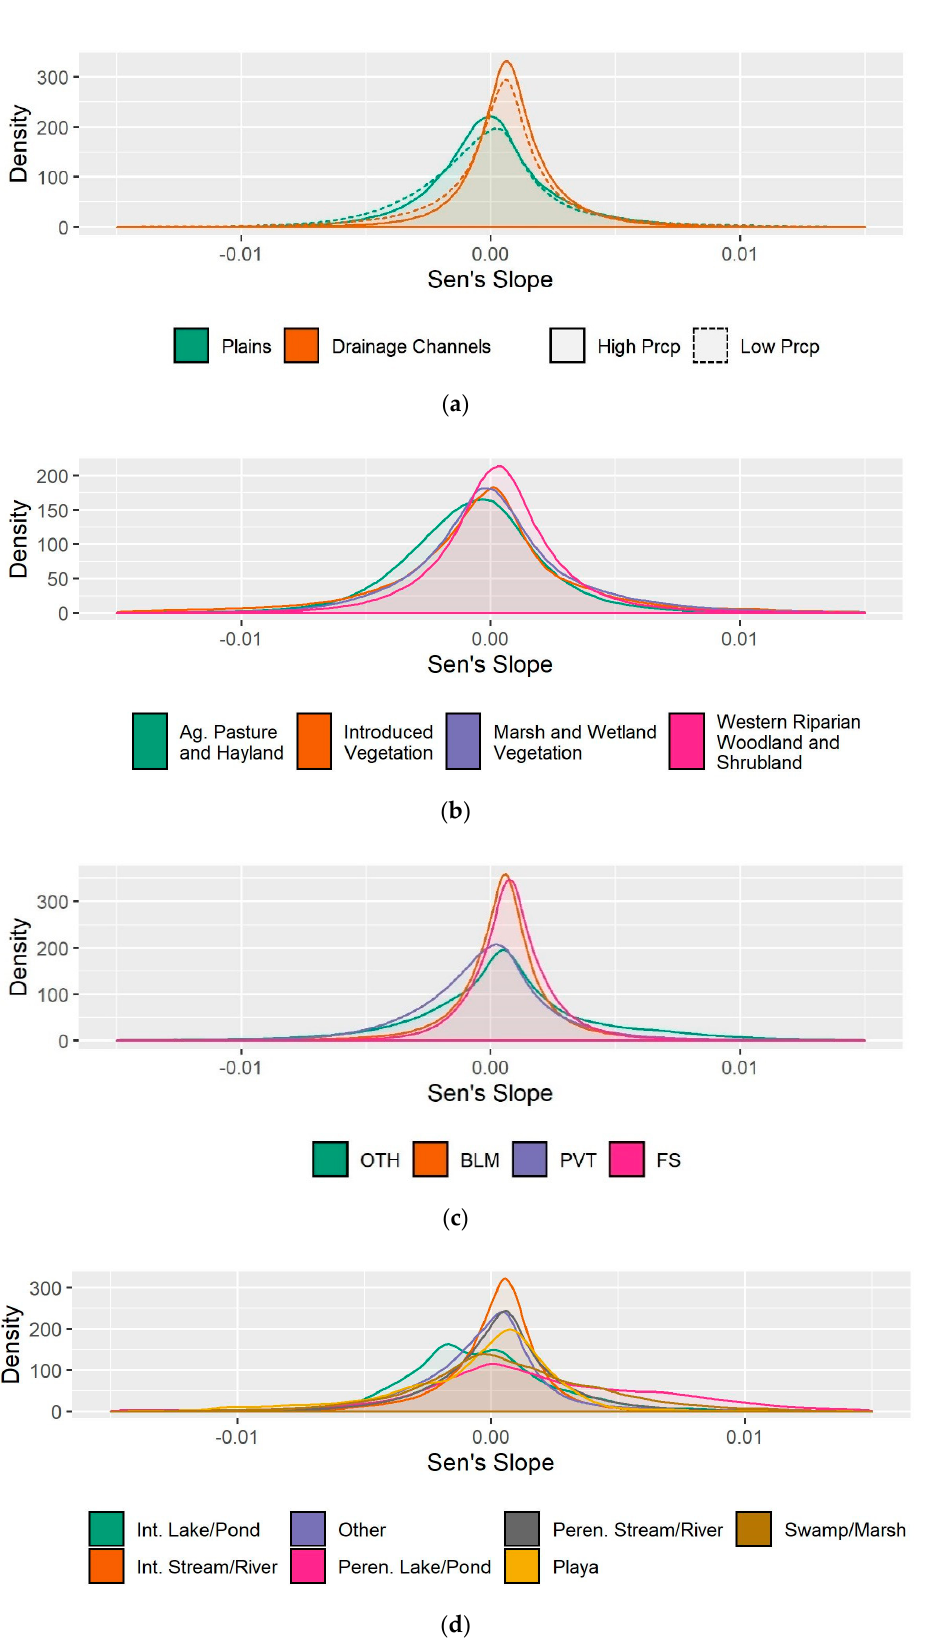
Figure 6. Distributions of drought-adjusted Sen’s slopes for landform and precipitation classes ( a ), riparian land cover type ( b ), land ownership ( c ), and water bodies and streams ( d ).